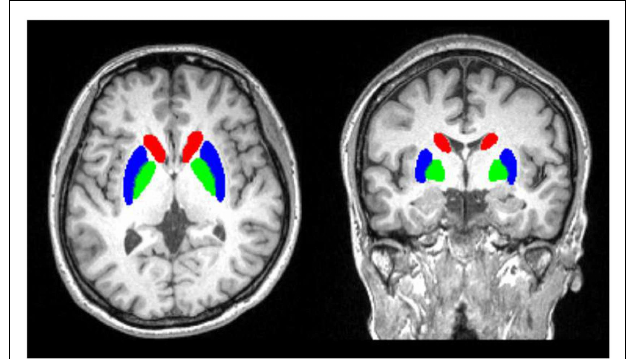
FIGURE 1 | Illustrations of semiautomated subcortical segmentation . The area is overlayed on the anatomical MRI of one of the subjects involved in this study.